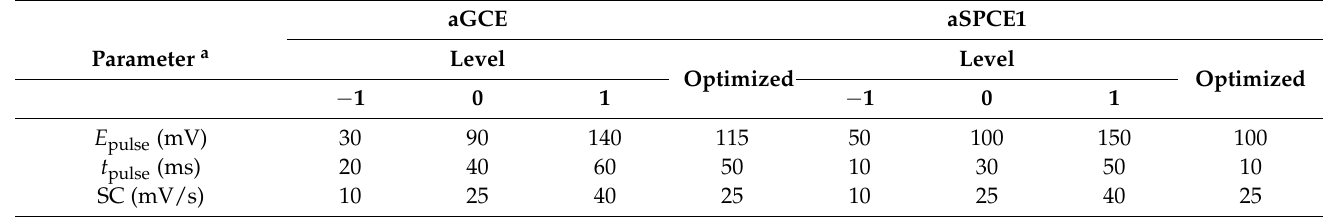
Table 2. Values of the applied measurement parameters the Design of Experiments and optimized parameters. aGCE aSPCE1